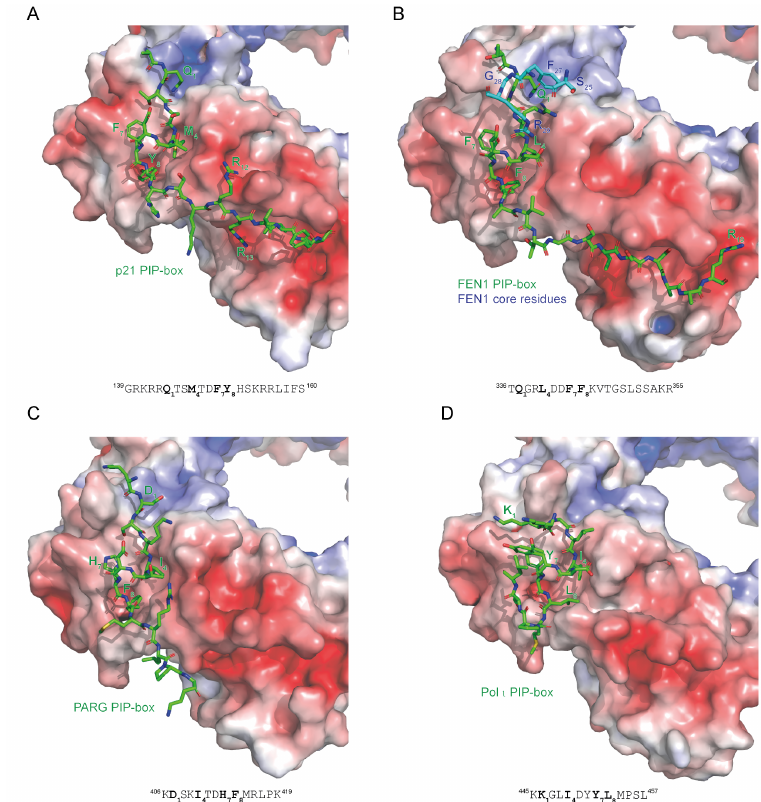
Figure 4. Different binding modes of PIP-box motifs to PCNA. Electrostatic surface potential of the interaction interface on PCNA and stick representation of PIP-box peptides in green are shown for ( A ) p21 (1AXC) [31], ( B ) FEN1 [38], ( C ) PARG [27], and ( D ) DNA polymerase τ (2ZVM) [21]. The sequences of PIP-box peptides are shown with the four critical residues indicated in bold.